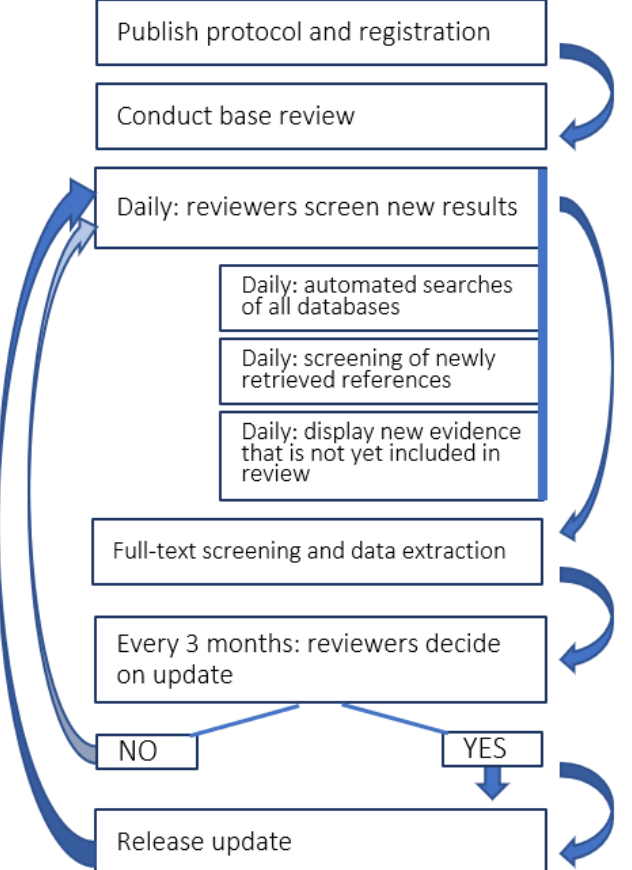
Figure 1. Workflow for updating the living systematic review. The process will be supported using automation technology and at three-monthly intervals the team will update the published version of the